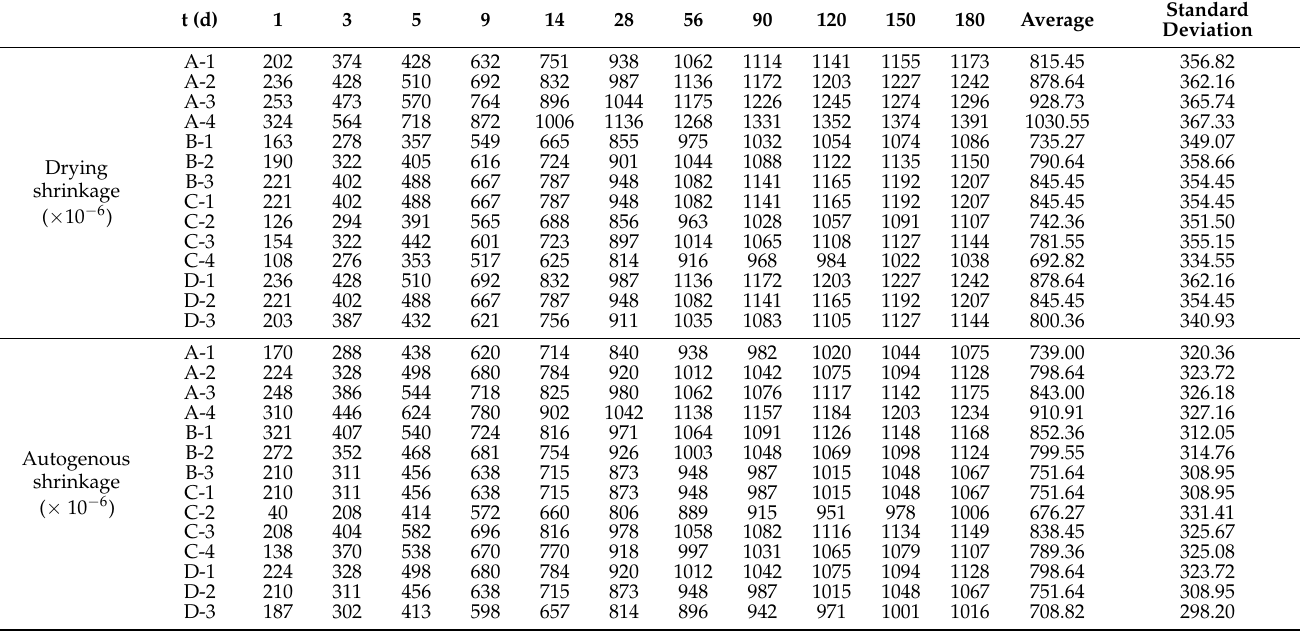
Table 7. The results of the shrinkage values, average, and standard